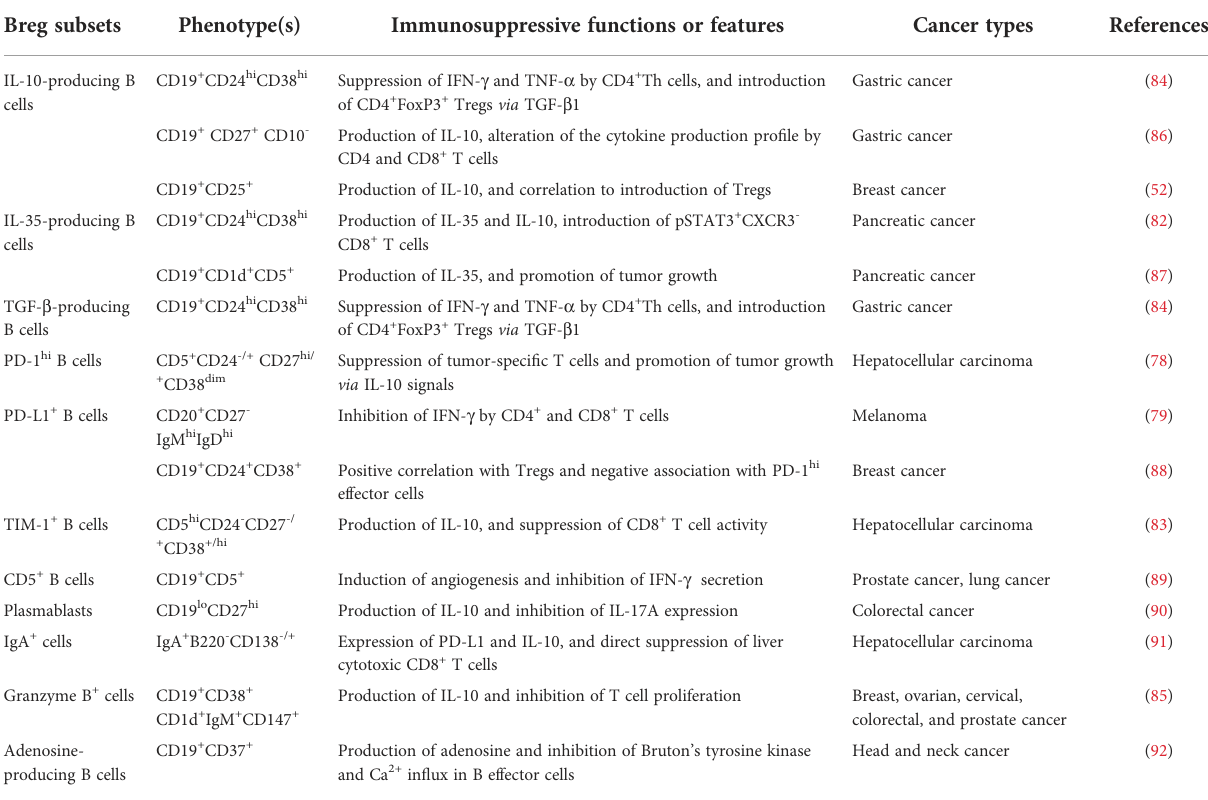
TABLE 1 Breg phenotypes in human solid